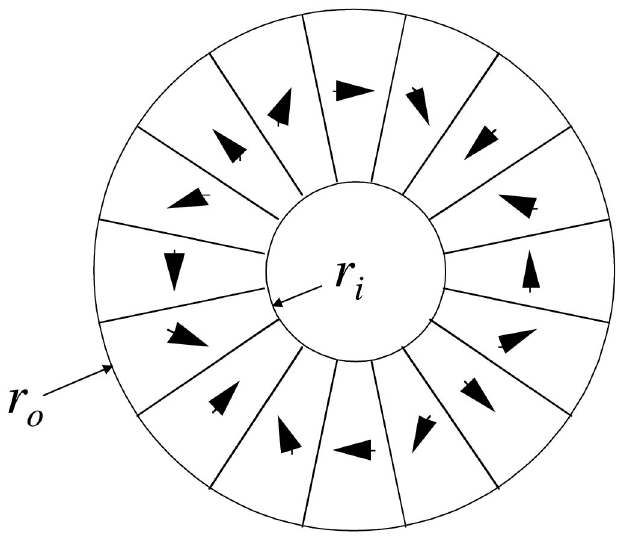
FIG. 1. A cross section of the 16 segment PMQ and the magnetization orientations shown as